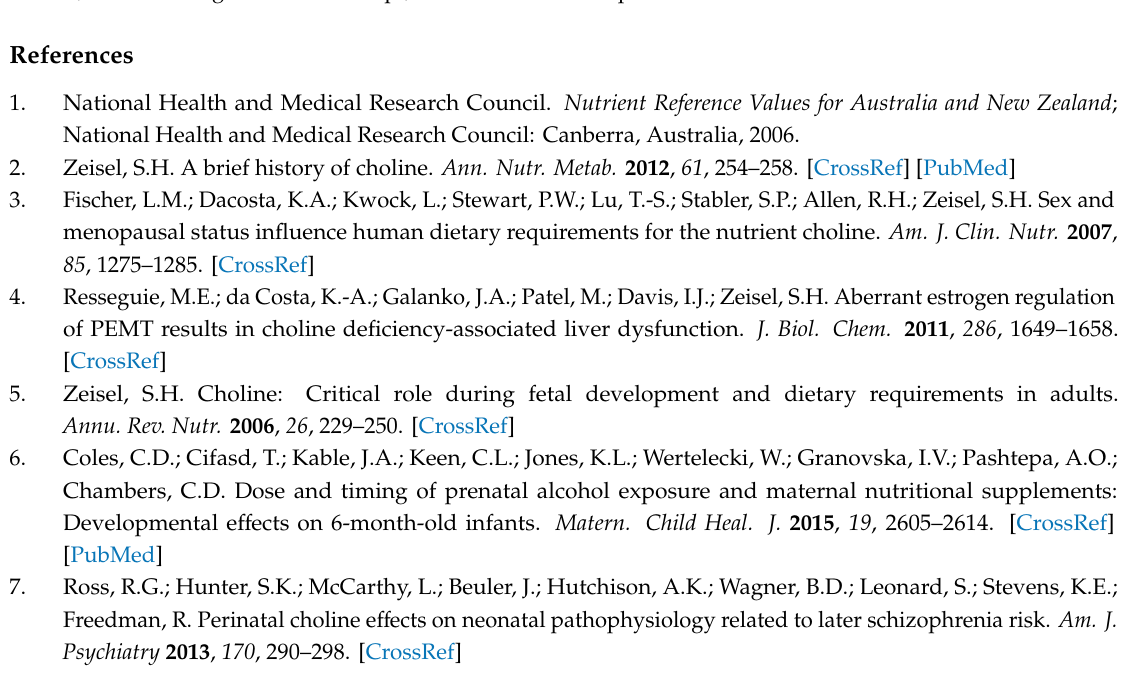
Figure S1: PRISMA flow diagram of literature search, Figure S2: PRISMA Checklist, Table S1: Proportion of young children intakes of choline by food group, Table S2: Average intakes for male consumers of choline by food group, Table S3: Average intakes for female consumers of choline by food group, Table S4: Average intakes for pregnant and lactating female consumers of choline by food